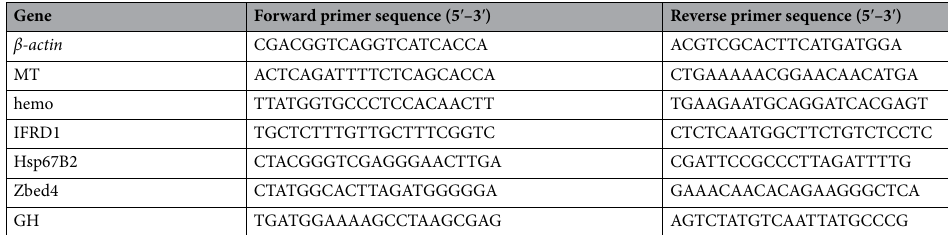
Table 4. Real-time quantitative PCR primers used in this study. MT metallothionein, Hemo hemocyanin-like protein, IFRD1 interferon-related developmental regulator 1, Hsp67B2 heat shock protein 67B2-like, Zbed4 zinc finger BED domain-containing protein 4-like, GH gamma-glutamyl